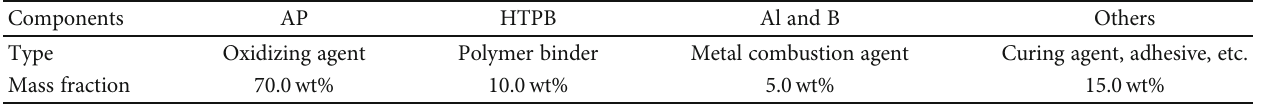
Table 1: The general components of the pasty propellant ingredient.